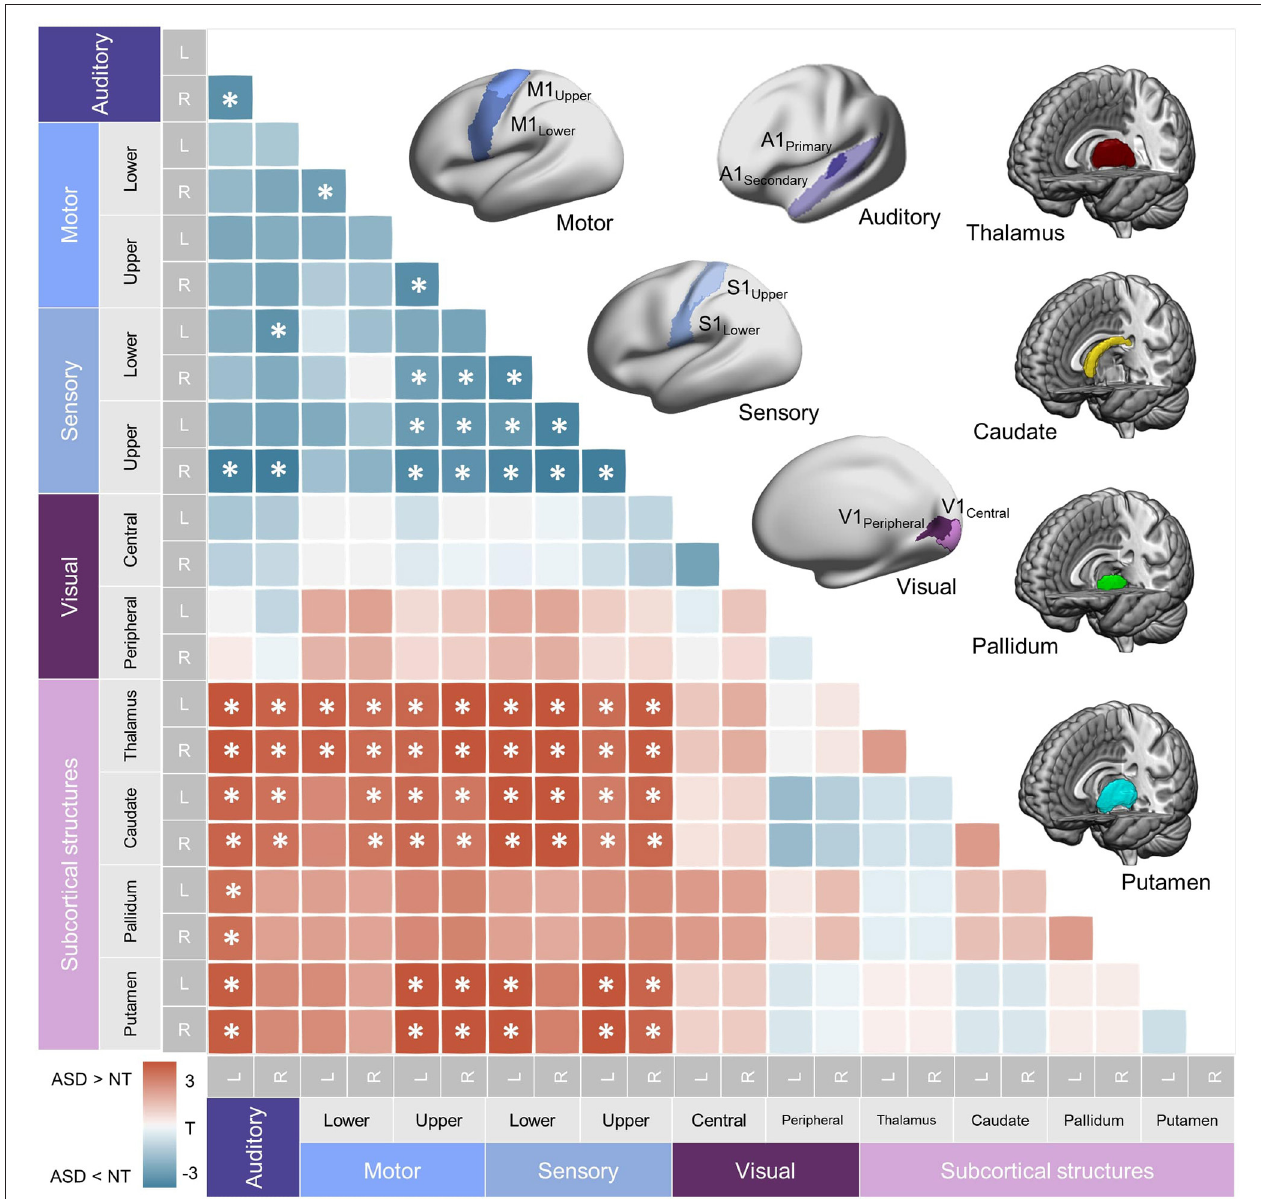
FIGURE 2 | Subcortical-primary sensory/motor network. Top right. Parcellations used for the seed-based functional connectivity analysis of within-primary sensory/motor and subcortical networks are shown. (See Materials and methods for details.) Bottom left. A heatmap representing correlation coefficients of intrinsic functional connectivity (iFC) in subcortical-primary/motor networks. Significant group differences are shown with asterisks (FDR = 0.05). Hypoconnectivity (ASD < NT) was found in the within-primary sensory/motor network, and hyperconnectivity (ASD > NT) was found between subcortical structures and sensory/motor cortices, collectively suggesting an atypical diverging pattern of iFC in ASD. L, left; R, right; NT, Neurotypical controls; ASD, Autism Spectrum Disorder.